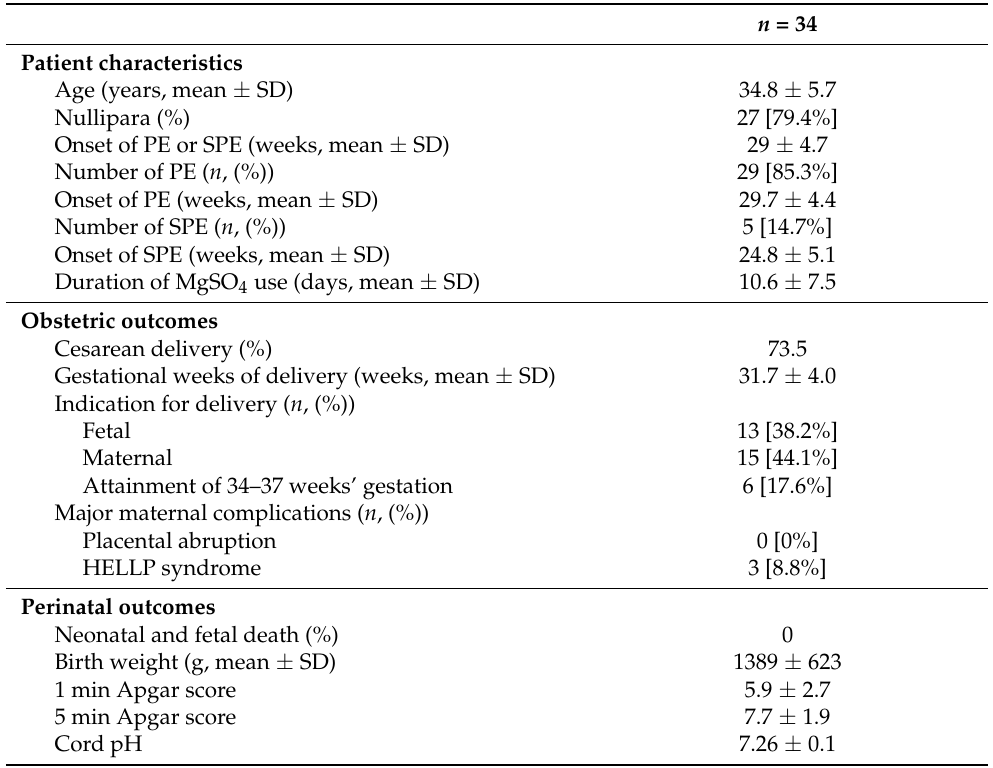
Table 2. Patient characteristics and obstetric and perinatal outcomes in the MgSO 4 treatment group. PE: preeclampsia; SPE: superimposed preeclampsia.